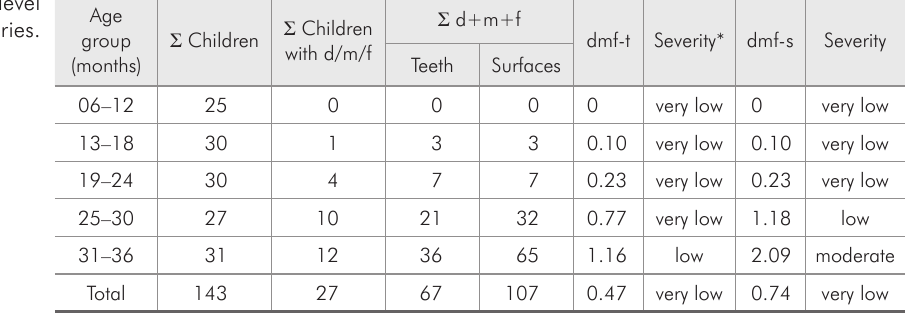
Table 3 - Severity level of